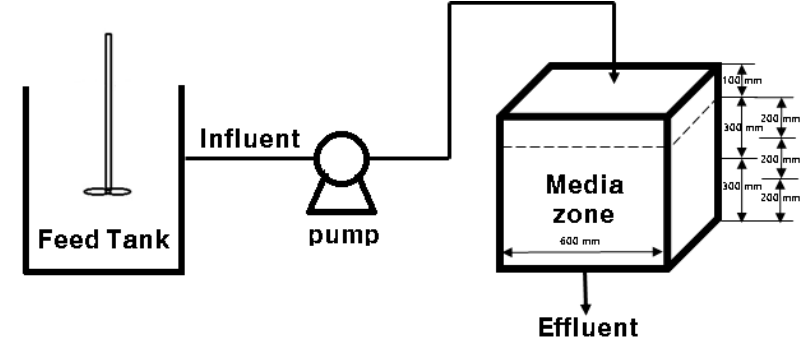
Figure 1. Schematic of experiment reactor.